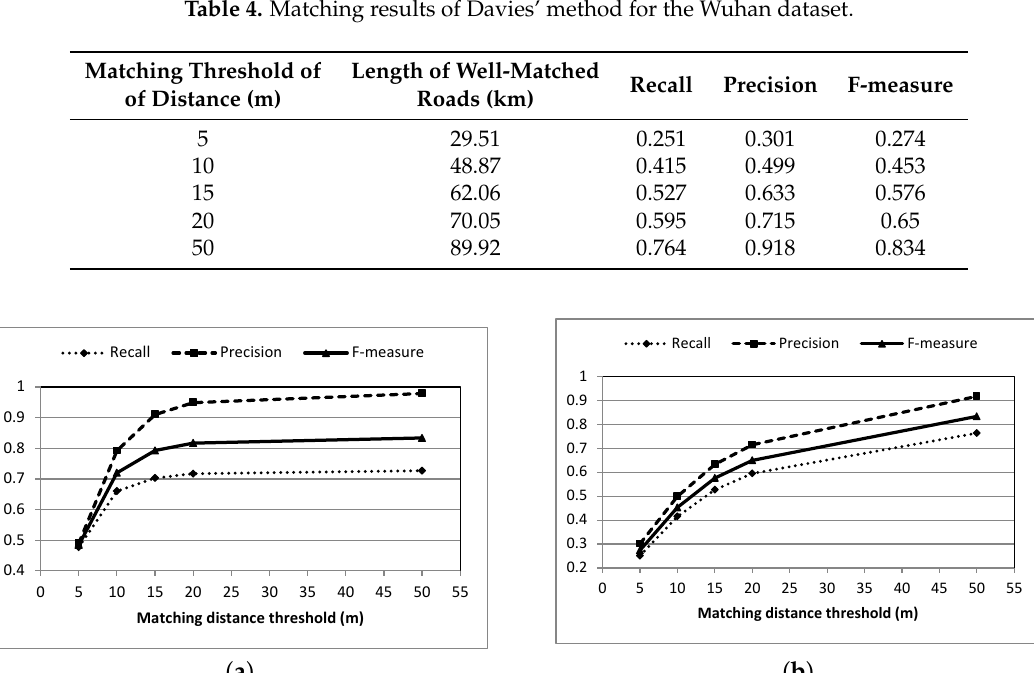
Figure 9. Comparison of our method and Davies’ method for the Wuhan dataset. ( a ) Recall, precision and F-measure of our method for the Wuhan dataset; ( b ) recall, precision and F-measure of Davies’ method for the Wuhan